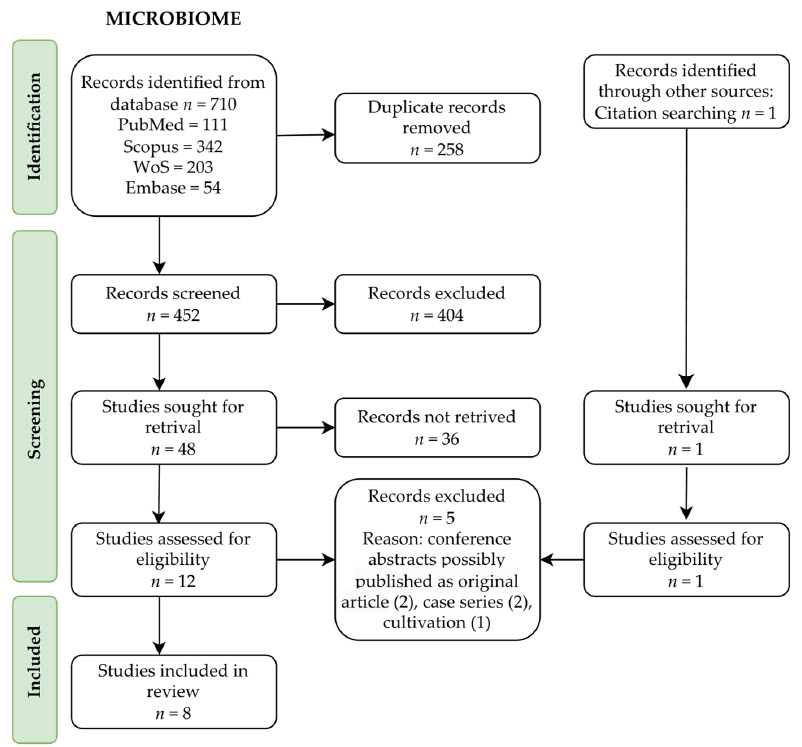
Figure 1. Flow diagram regarding microbiome ‐ related studies.